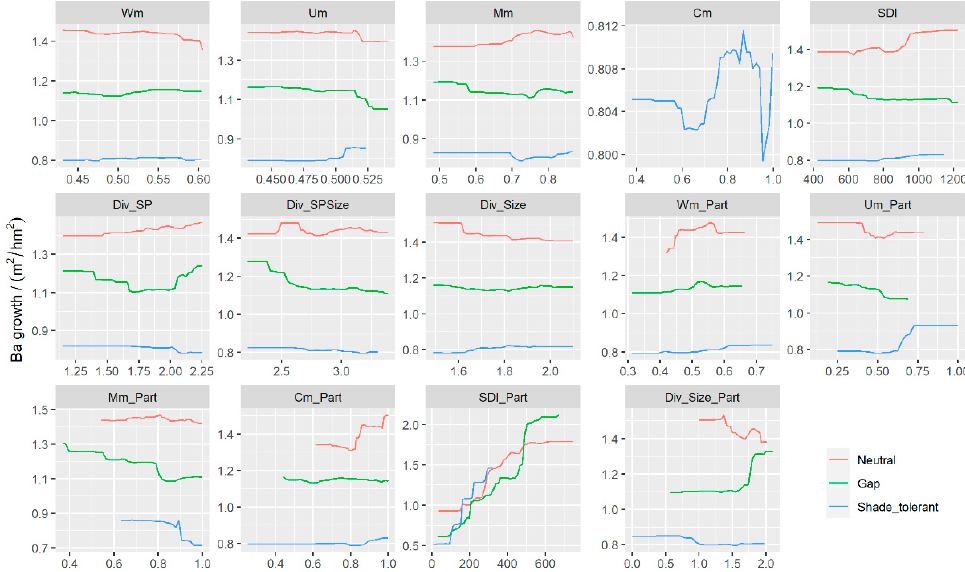
Figure 3. Basal area increment (BAI) of tree-species-groups simulations in relation to the most- important predictor